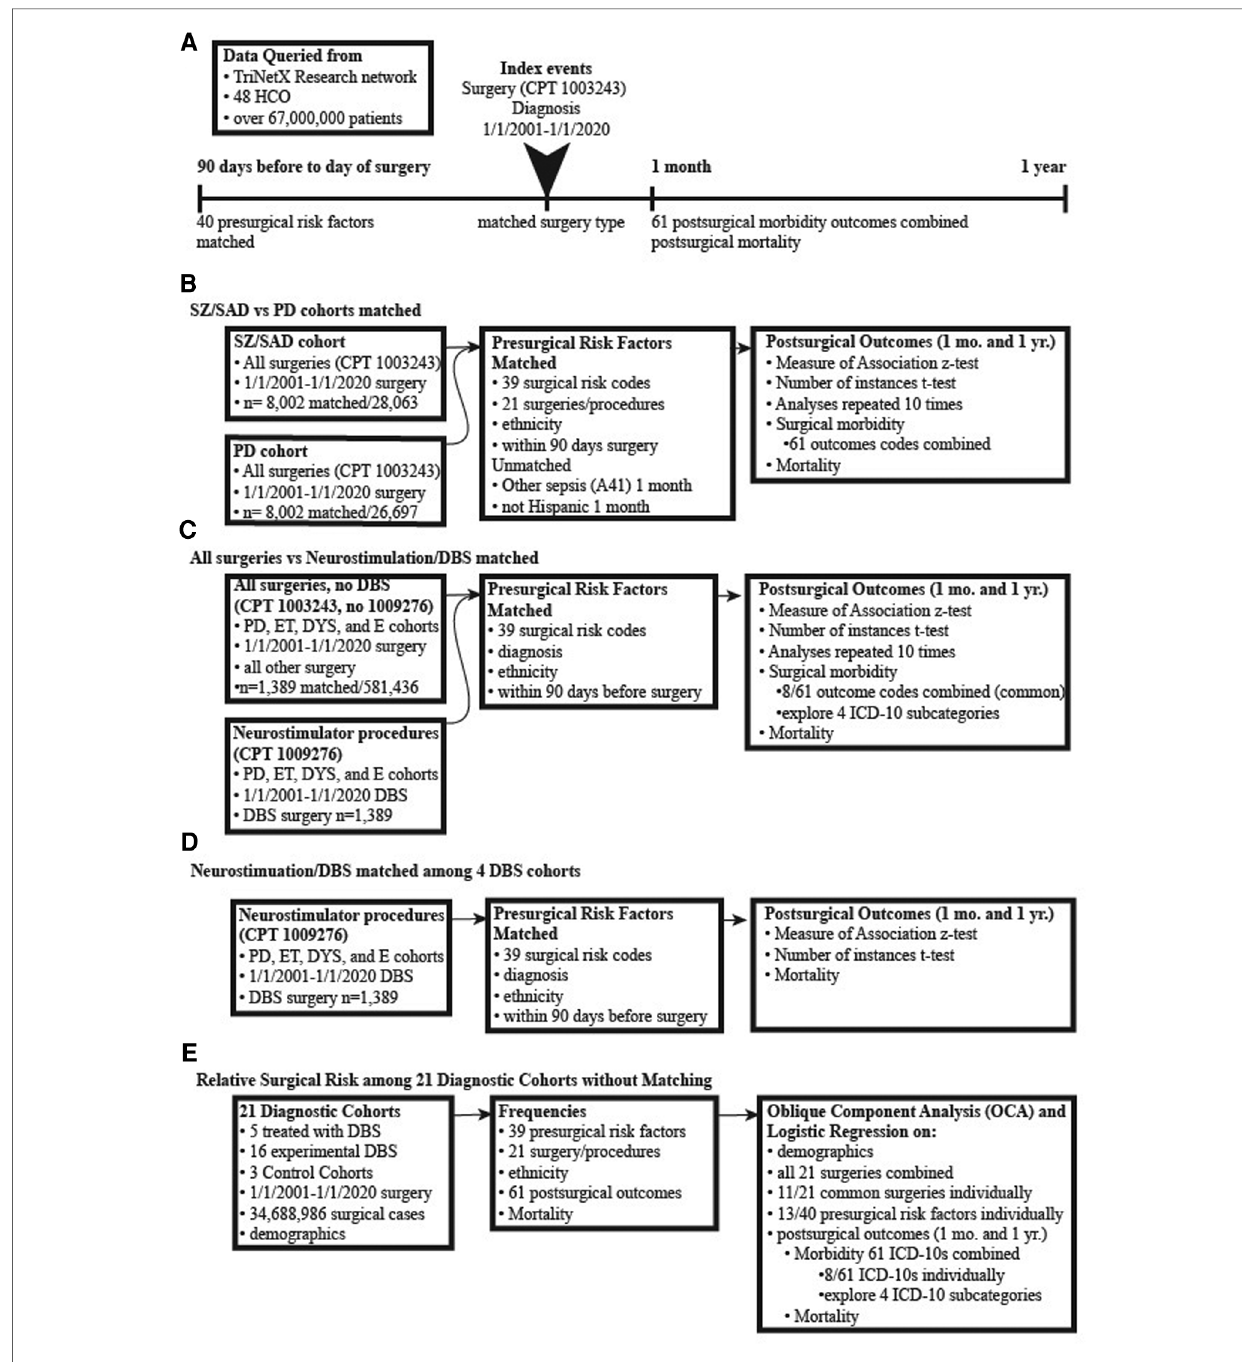
FIGURE 1 Pipelines of surgical data collection and analysis. ( A ) Cohorts were generated by database queries that included having a surgical procedure and diagnoses of interest (both were the index event). Matching occurred between factors occurring 90 days to the day of surgery. The postsurgical outcomes were analyzed at 1 month and 1 year. ( B ) Surgical outcomes of subjects diagnosed with either schizophrenia or schizoaffective disorder (SZ/SAD) were compared with subjects with Parkinson ’ s disease (PD). The SZ/SAD and PD cohorts were matched for surgical risk factors and type of surgical procedures. ( C ) Subjects with a PD, essential tremor, dystonia, or epilepsy diagnosis were split into two cohorts, one with neurostimulation surgical procedures or with all other surgeries combined. Cohorts were matched for presurgical factors and diagnoses to determine the relative frequencies of postsurgical morbidity and mortality. ( D ) Matched analyses of DBS postsurgical (after 1-month and 1- year) morbidity and mortality outcomes in PD, epilepsy, essential tremor, and dystonia where compared. ( E ) The frequencies of surgery, presurgical factors and postsurgical outcomes were tabulated for 21 unmatched diagnostic cohorts and 3 controls